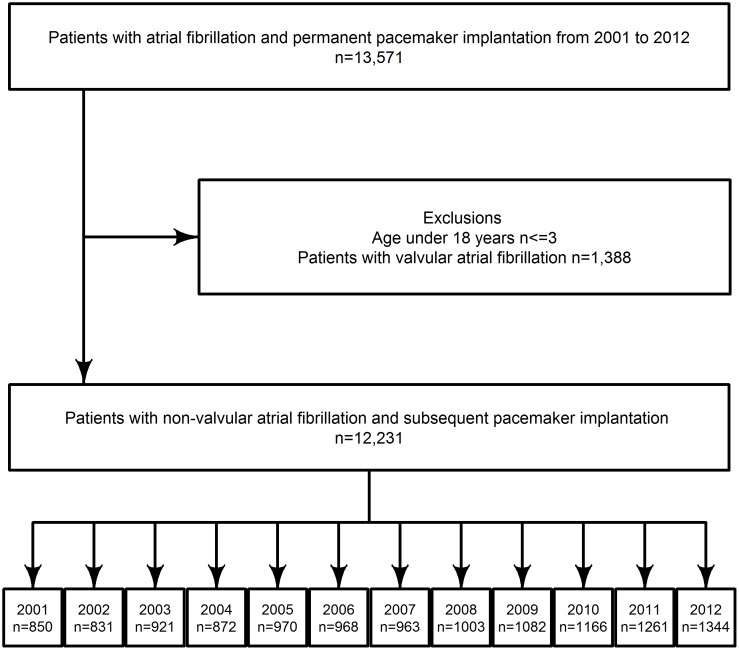
Flowchart.Flowchart inclusion of the study cohort. Stratified by year of pacemaker implantation date.